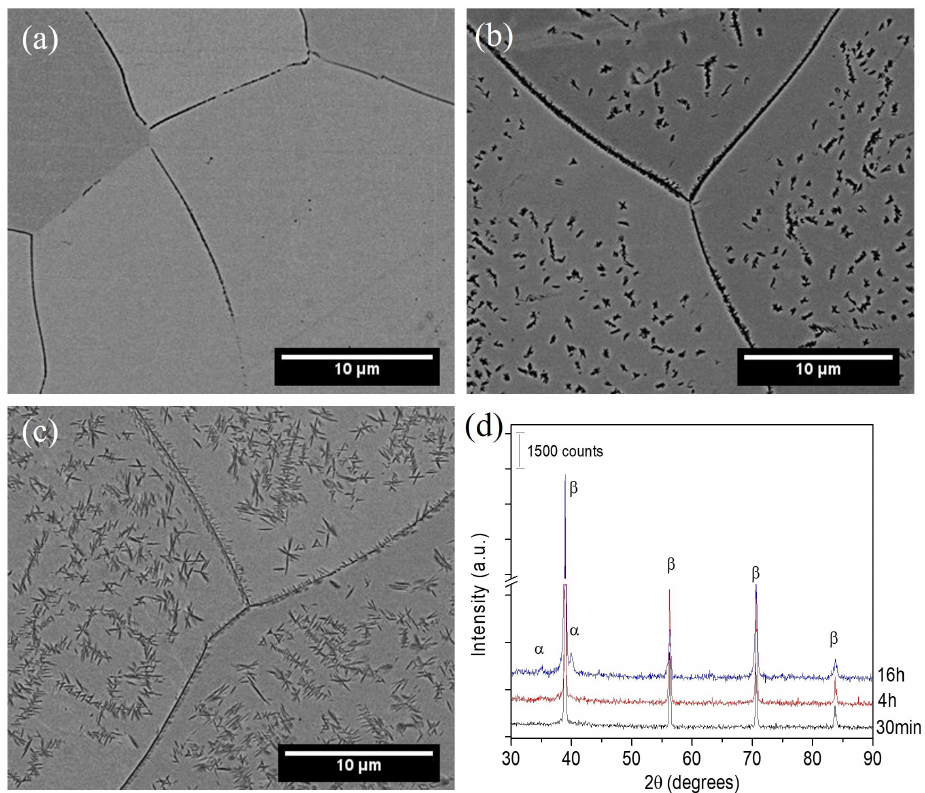
Figure 6. Microstructures of Ti-30Nb-3Fe alloy treated at 500 ºC, applying a heating rate of 30 ºC/min for (a) 30 min, (b) 4 h, (c) 16 h and (d) XRD patterns of each of the aged samples. SEM micrographs recorded in backscattered electron imaging mode with unetched samples.